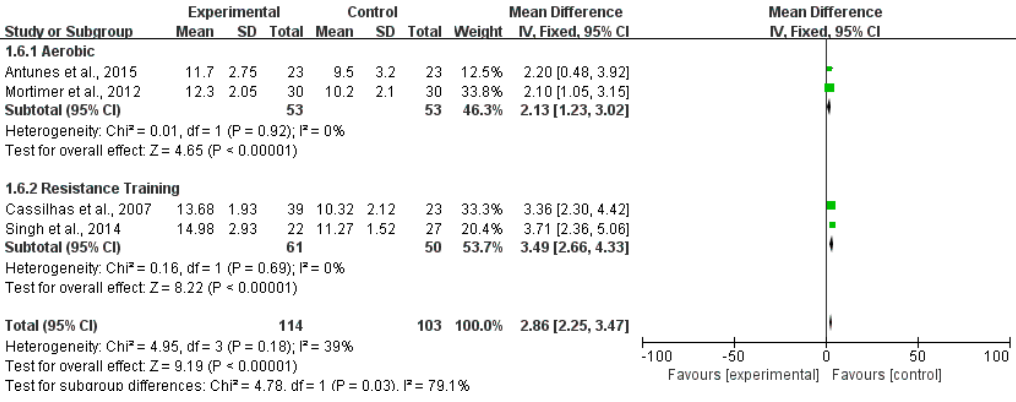
Figure 5. Forest plots of WAIS scale outcomes in overall analysis [12,16,23,24].